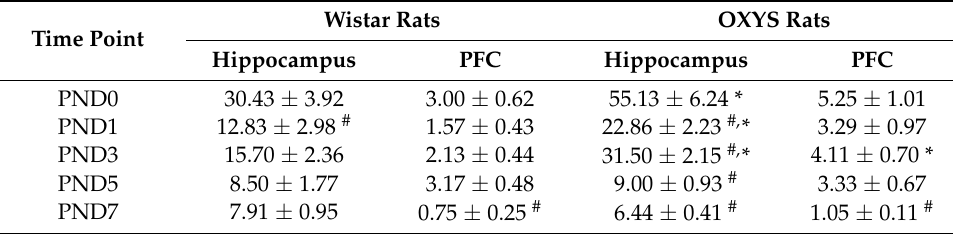
Table 6. The number of apoptotic cells in the hippocampus and PFC of OXYS and Wistar pups. Wistar Rats OXYS Rats Time Point Hippocampus PFC Hippocampus